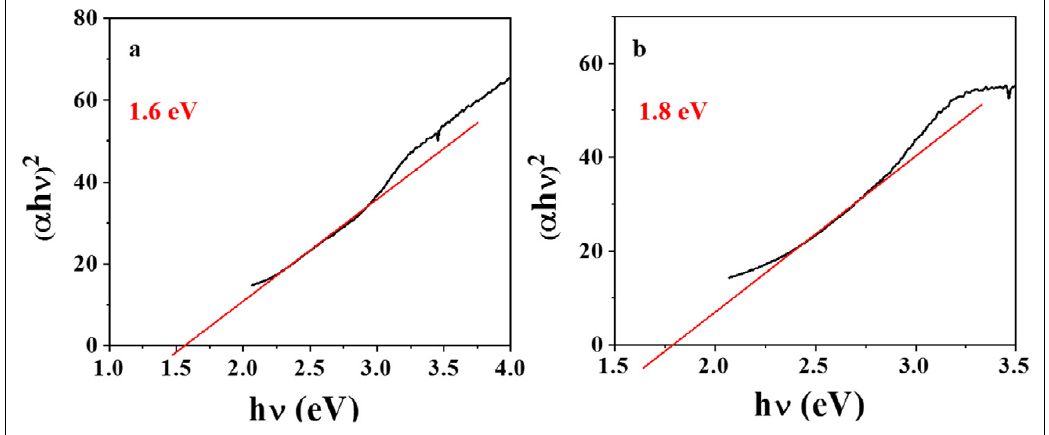
Fig. 3. Tauc plot obtained UV-Vis spectra of the as-prepared Cr 2 O 3 nanoparticles at a) 500 ºC and b) 600 ºC